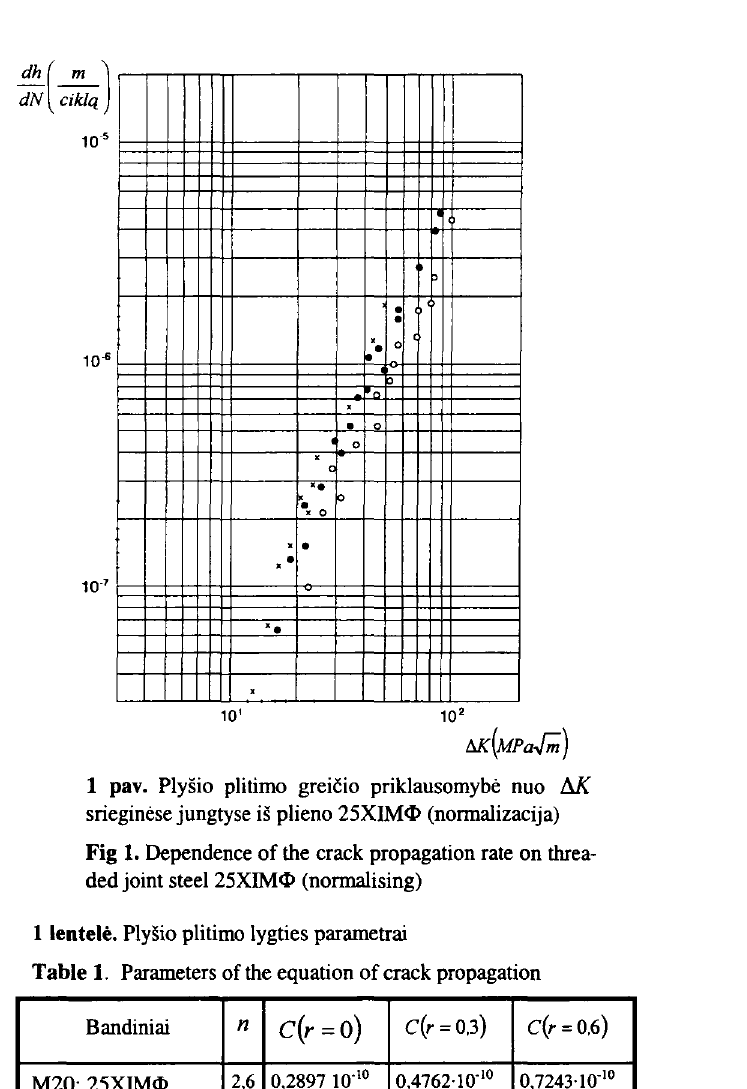
Fig 1. Dependence of the crack propagation rate on threa ded joint steel25XIM<I> (normalising) 1 lentele. Plysio plitimo lygties parametrai Table 1. Parameters of the equation of crack propagation